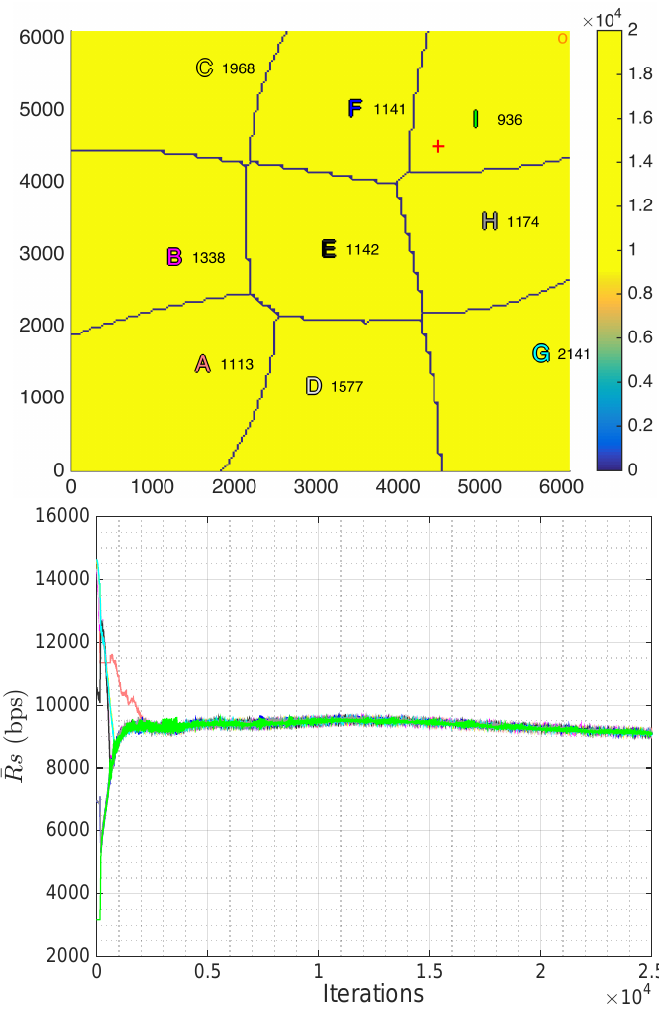
Figure 8. Rearrangement of UAVs when subscribers density returns to uniform: positions and coverage areas ( top ); and evolution of the rate per user in each coverage area ( bottom ). Each color in the bottom figure represents one coverage area using the same colors as the ones assigned to letters in the top